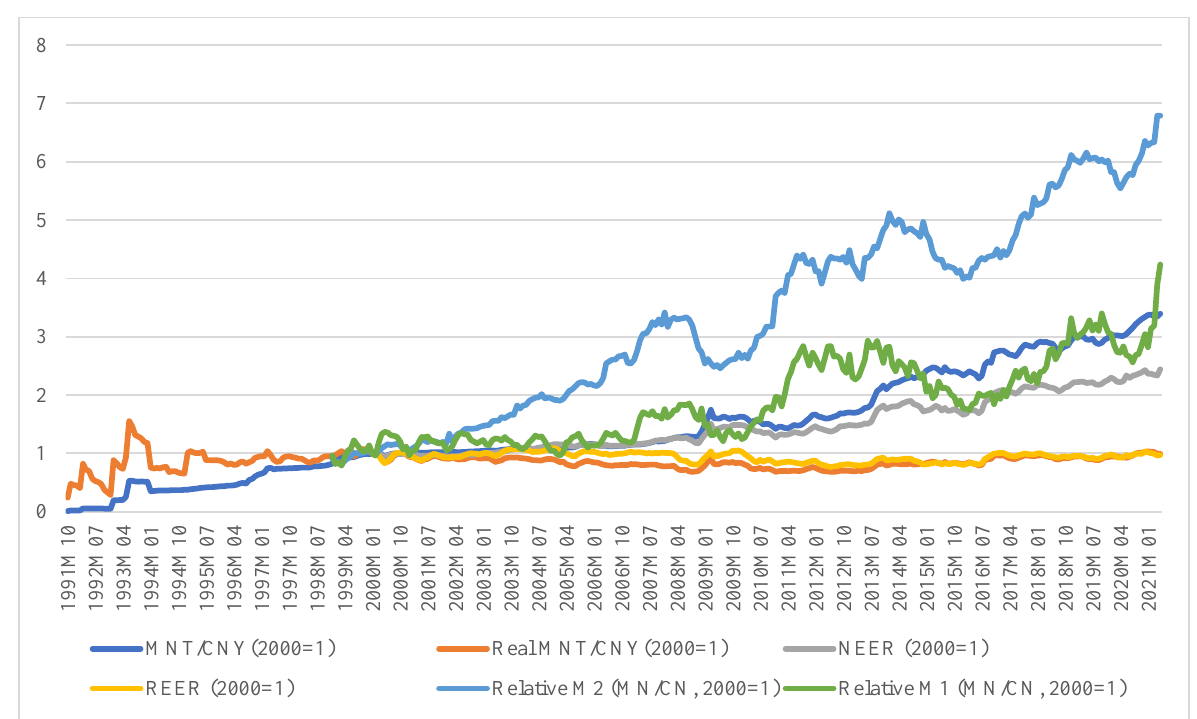
Figure 2. Exchange rate and relative money supply. Source: Author’s estimation based on publicly available data from National Statistical Office, the BoM, and IFS, IMF. Note: MNT/CNY-Nominal exchange rate per Chinese Yuan in terms of Mongolian Tugrik. The BoM’s NEER and REER series are inverted to be consistent with our other measures. Relative money supply is the ratio of monetary aggregates of Mongolia to those of China.